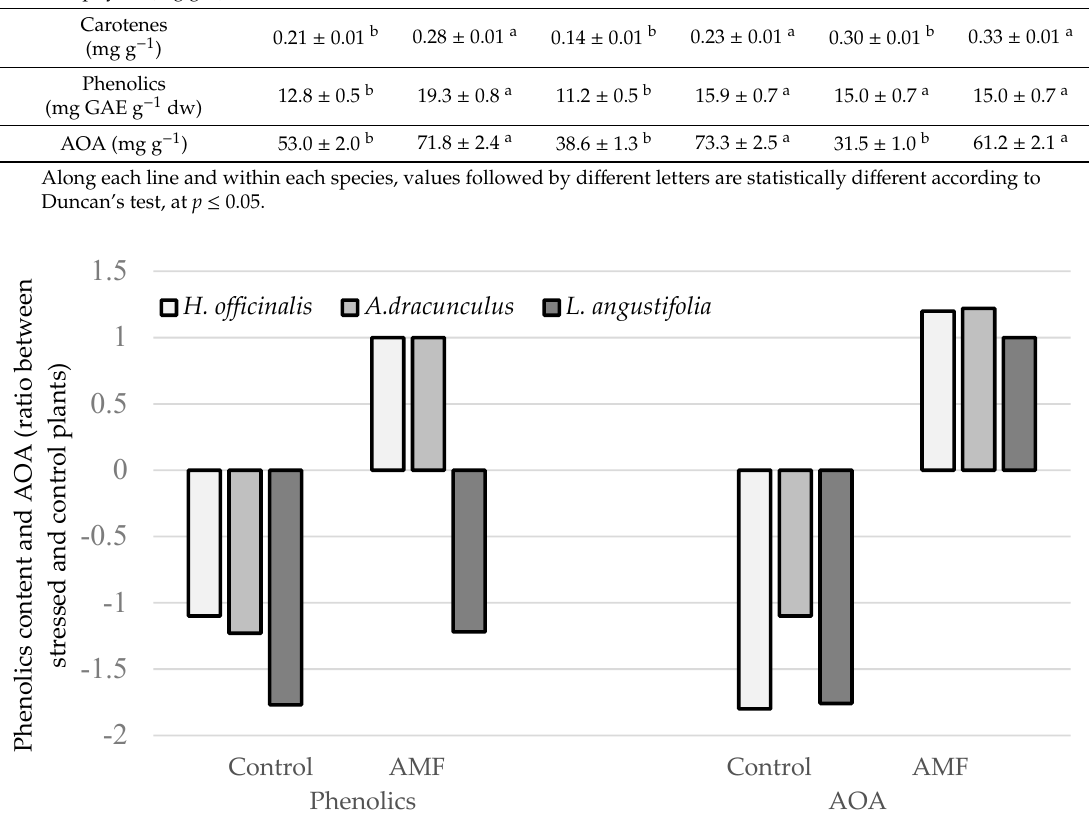
Table 3. Effect of AMF inoculation on plant antioxidant compounds and activity of aromatic species subjected to abiotic stress after harvesting.